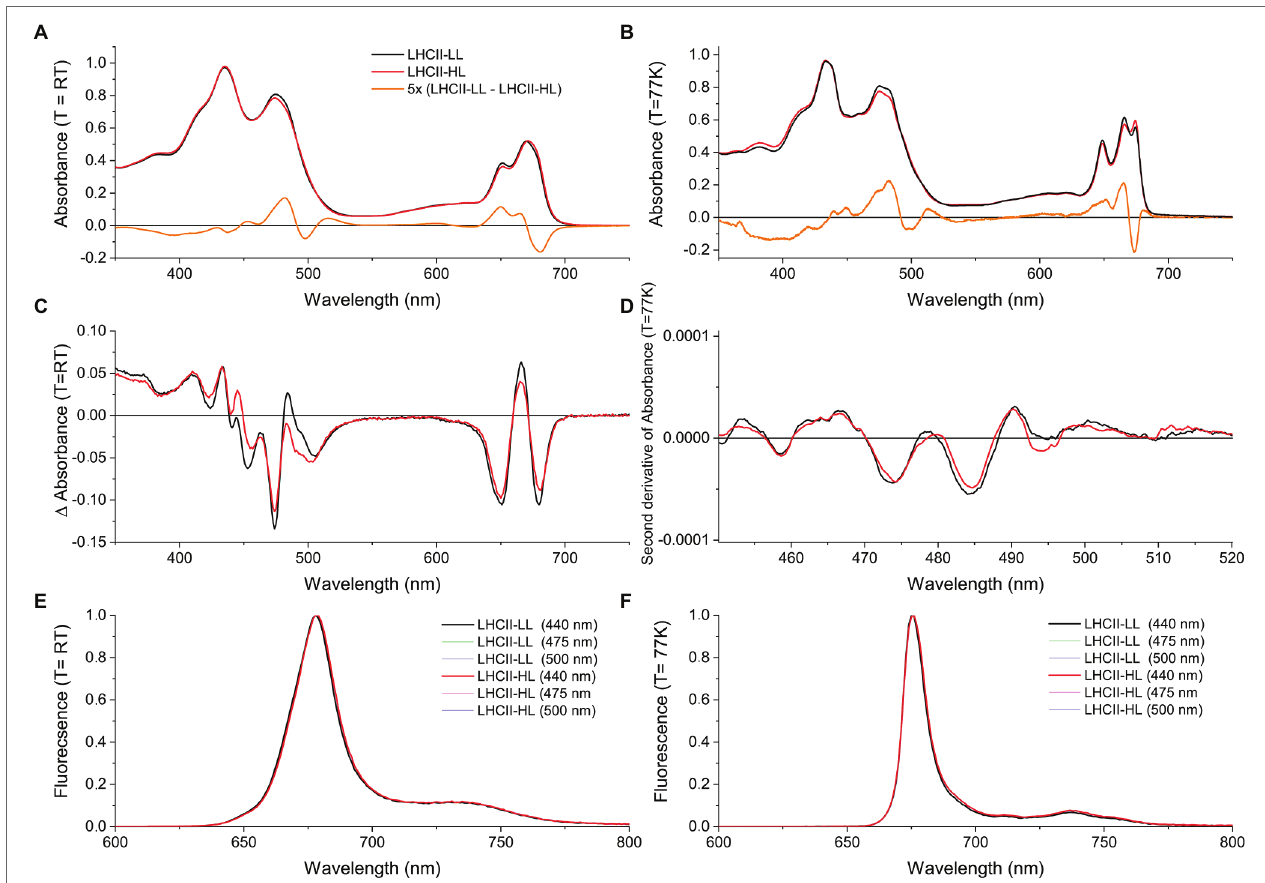
FIGURE 4 | Steady-state spectra of LHCII purified from long-term LL (LHCII-LL) and HL (LHCII-HL) acclimated cells. (A) Absorption spectra at room temperature (RT) and (B) at 77 K normalized to the area in the 620–700 nm region. (C) Circular dichroism (CD) spectra at RT normalized to the respective absorption spectra. (D) Savitski-golay smoothed (20 pt) second derivative of the 77 K absorption spectrum. (E) Fluorescence emission spectra at room temperature and (F) at 77 K. Different excitation wavelengths (440, 475, and 500 nm) gave similar results for both samples. Some of the spectra are virtually identical and are thus not all visible in the figure. Results were reproduced on three biological replicates or two biological replicates in the case of the 77 K absorption.